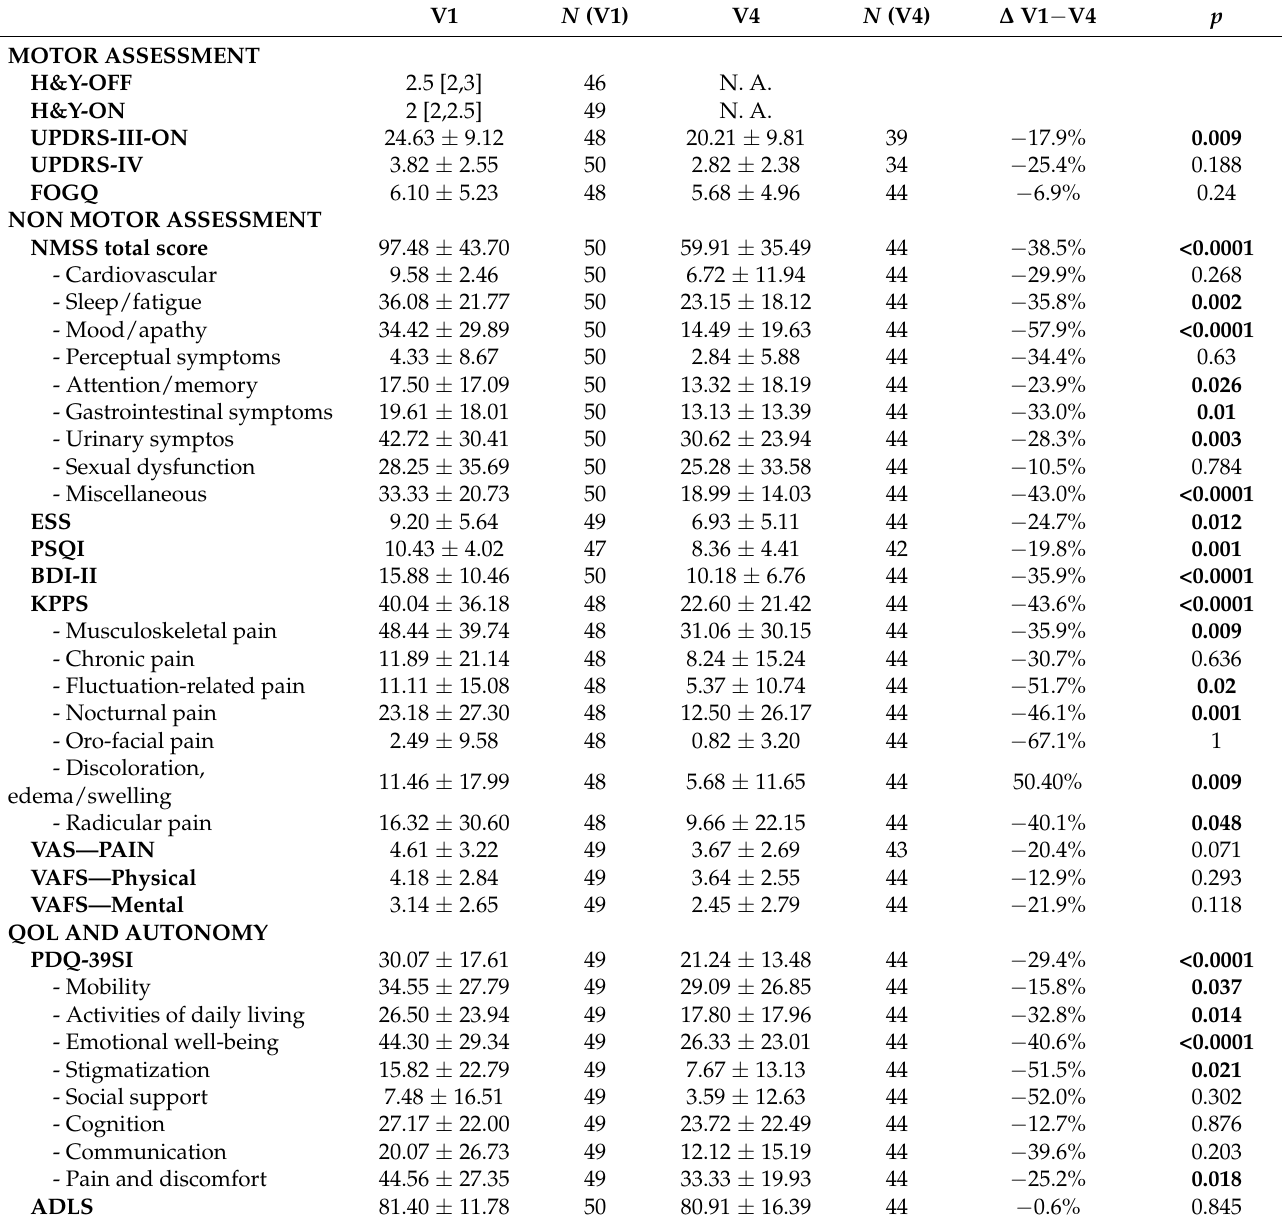
Table 2. Change in the score of the non-motor symptoms scale (NMSS) and other scales of the study from V1 (baseline) to V4 (6 months ± 15